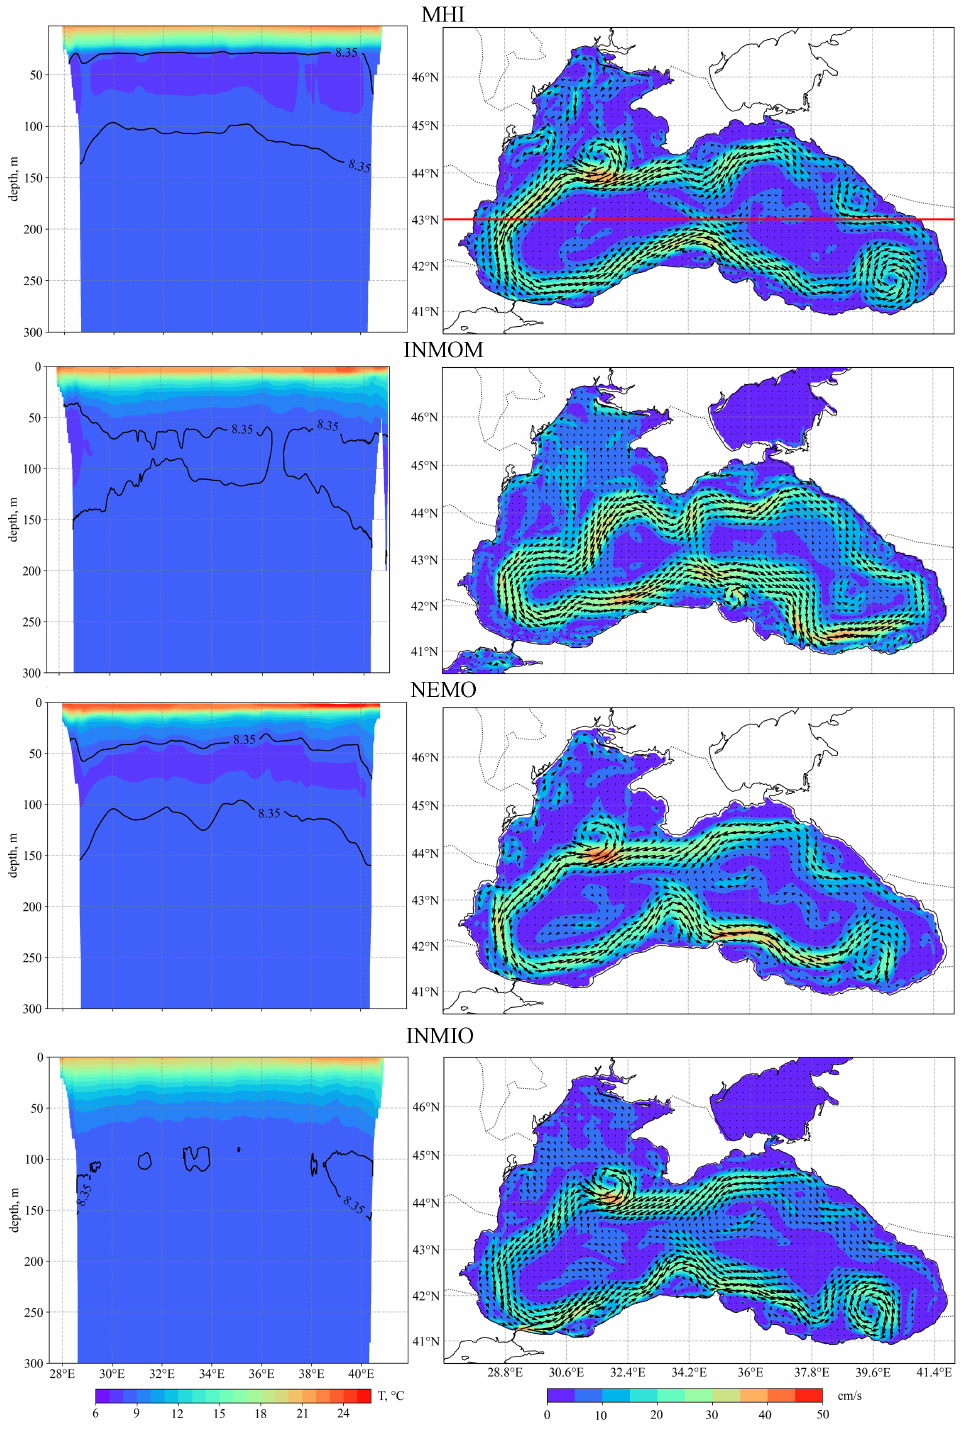
Figure 2. Monthly mean temperature in the section along 43 ◦ N (left panels) and current velocities at the upper model horizon (right panels) according to the four models for June 2011. Red line is the zonal section along 43 ◦